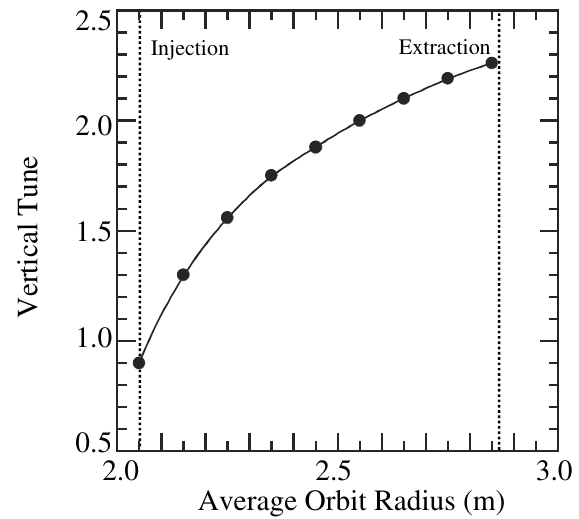
FIG. 12. Vertical tune shifts for the case of the LE ring. A pole gap of 1 cm is assumed and the vertical tune at injection is adjusted to the value listed in Table V, using the linear optical model described in the text.